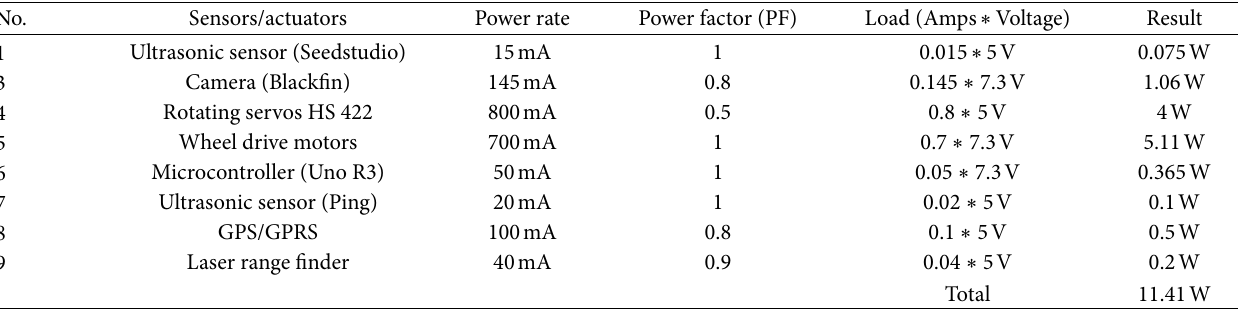
Table 4: Components and loads in robot 3.